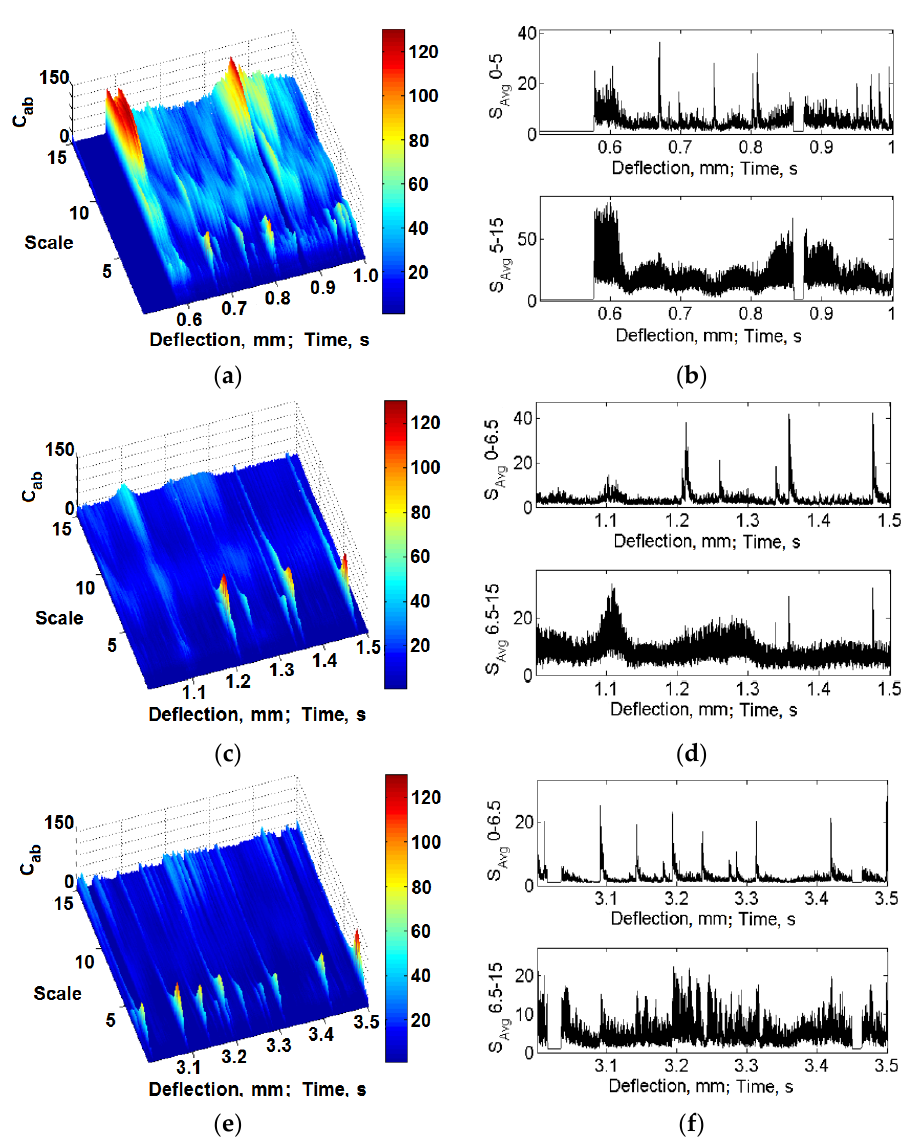
Figure 15. Exemplary time frequency scale distributions and averaged values, initial deflection: ( a – b ) Classic laminate; ( c – d ) 3D ‐ W laminate; ( e – f ) 3D ‐ P laminate.